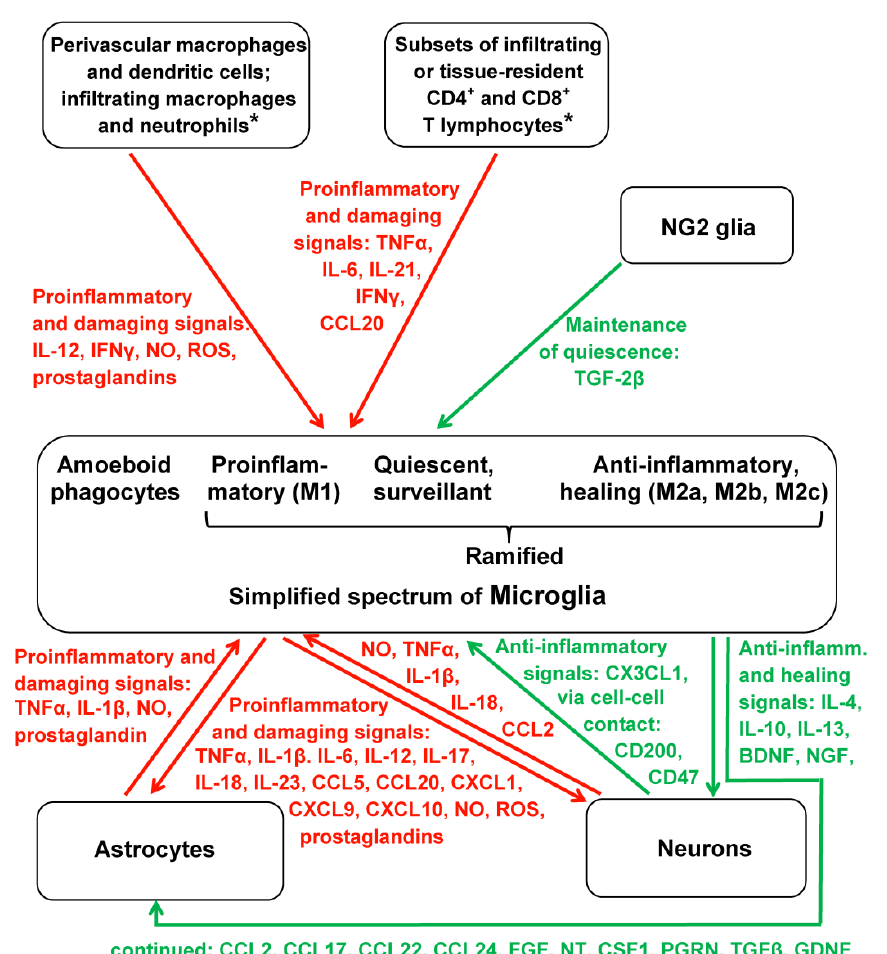
Figure 1. Overview of microglial subtypes and their pro- and anti-inflammatory cellular environment. Proinflammatory interactions and factors are depicted in red, anti-inflammatory interactions and factors are depicted in green. Asterisks (*) indicate a higher complexity of signaling and, in the case of T lymphocytes, a higher diversity of subtypes. Generally, the complexity of interactions is even higher and also concerns differences between various diseases, but the figure had to be kept within an intelligible frame. Damaging factors caused by dying cells at sites of injury have been omitted; this would especially play a role in the focal activation that causes the transformation of ramified microglial cells into amoeboid phagocytes. Additional signaling via microRNAs and other constituents of exosomes has been also omitted. Abbreviations: BDNF, brain-derived neurotrophic factor; CCL, CXCL, and CX3CL refer to the respective chemokine families; CD, cluster of differentiation; CSF1, colony-stimulating factor-1; FGF, fibroblast growth factor; GDNF, glia-derived neurotrophic factor; IFNγ, interferon-γ; IL, interleukin; NG2 glia, neural-glial-2 expressing cells; NGF, nerve growth factor; NO, nitric oxide; NT, neurotrophin (several subforms); PGRN, progranulin; ROS, reactive oxygen species; TNFα, tumor necrosis factor-α; TGFβ, transforming growth factor-β.